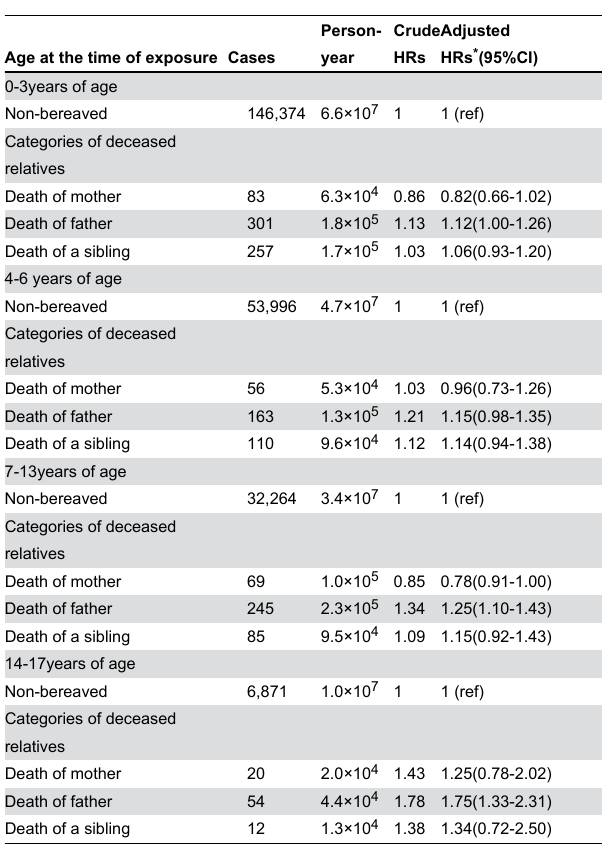
*. Adjusted for country, mother’s country of origin, maternal age at delivery, maternal parity, maternal social status at birth, sex of the child, low birth weight, calendar year of birth, and family history of asthma doi: